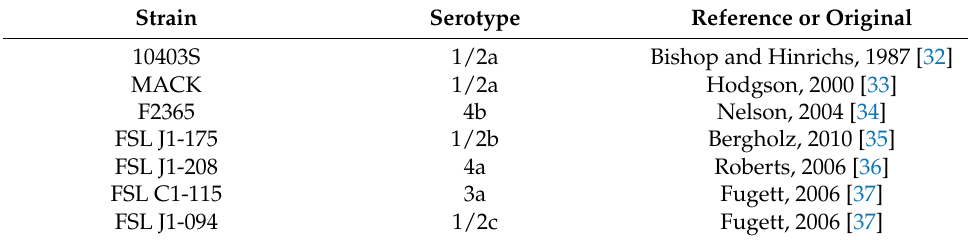
Table 1. Listeria monocytogenes